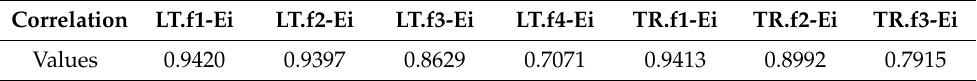
Table 9. Correlation of frequencies and Ei in LT and TR modes.